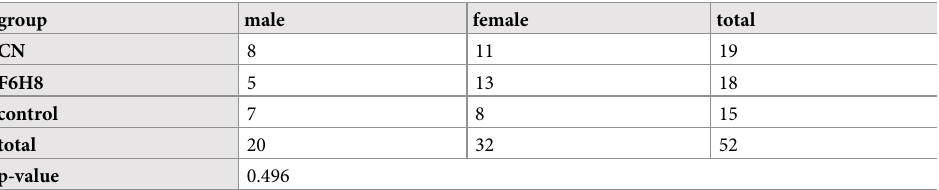
Table 3. Gender distribution (long term analysis group).